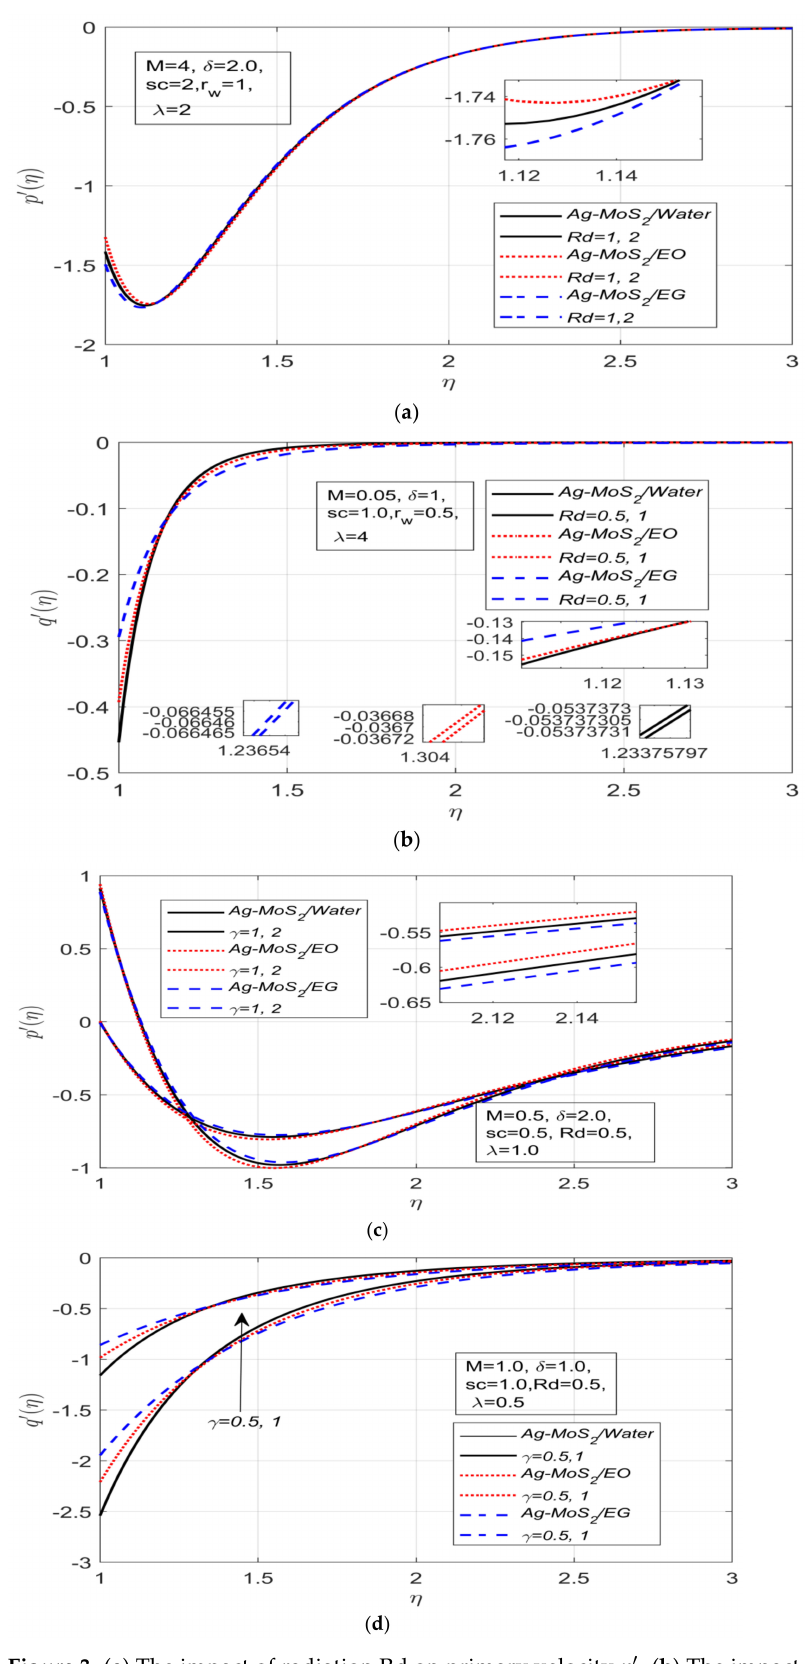
Figure 3. ( a ) The impact of radiation Rd on primary velocity p (cid:48) . ( b ) The impact of radiation Rd on secondary velocity q (cid:48) . ( c ) The impact of stretching ratio γ on the primary velocity p (cid:48) . ( d ) The impact of stretching ratio γ on thee secondary velocity q (cid:48)